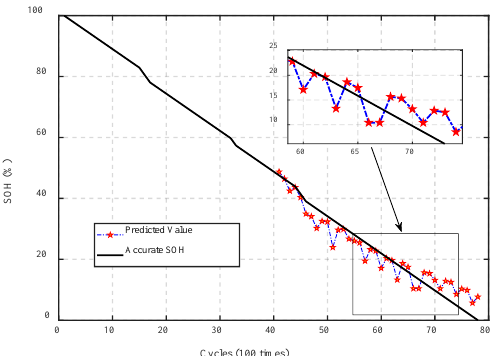
Figure 10. Reduced Battery #05 for Cell1 SOH prediction, the MAE of this result is 1.65% and the RMSE is 2.84%.